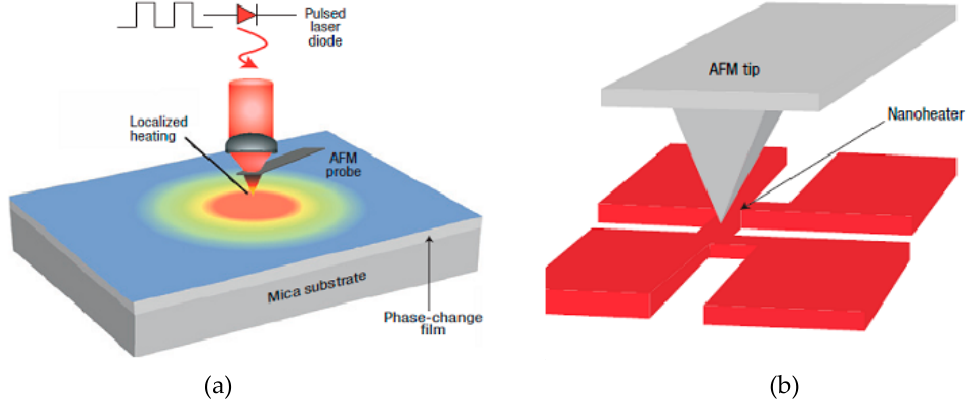
Figure 24. Schematic of the thermal probe storage system using phase change media when operated in ( a ) writing mode and ( b ) readout mode. Reproduced with permission from [54]. Copyright Nature, 2006. Table 2. Characteristics of phase-change electrical probe memories proposed by different groups.